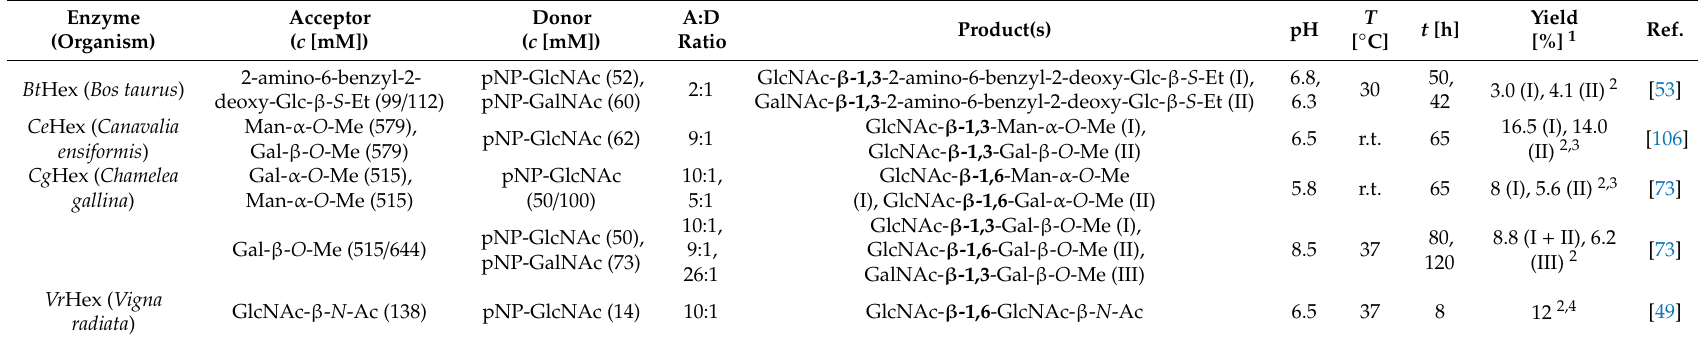
Table 6. Trans-glycosylation reactions catalyzed by mammalian, plant or mollusc GH20 β - N -acetylhexosaminidases using pNP-activated carbohydrate donor substrates. New bonds are highlighted in bold.